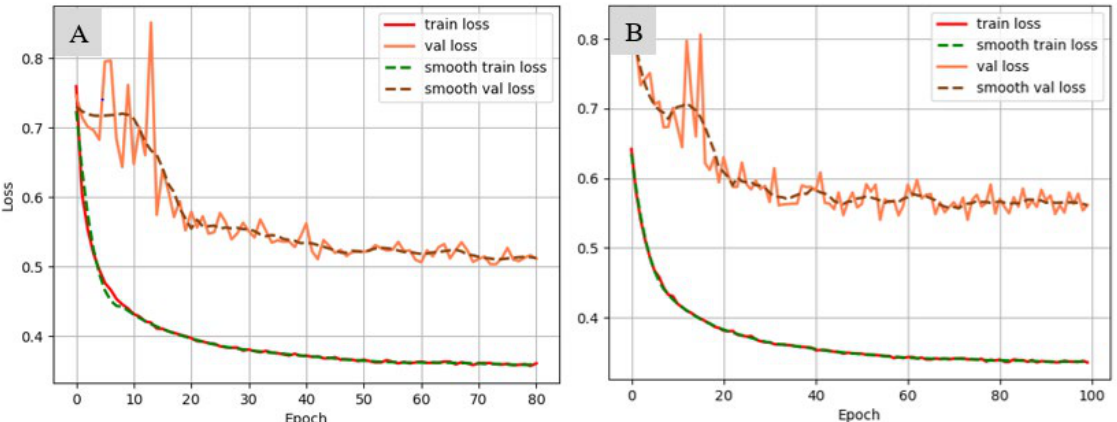
Figure 5. Loss curve for 6 categories ( A ) (including cropland, forest, shrubland, water, and imper-